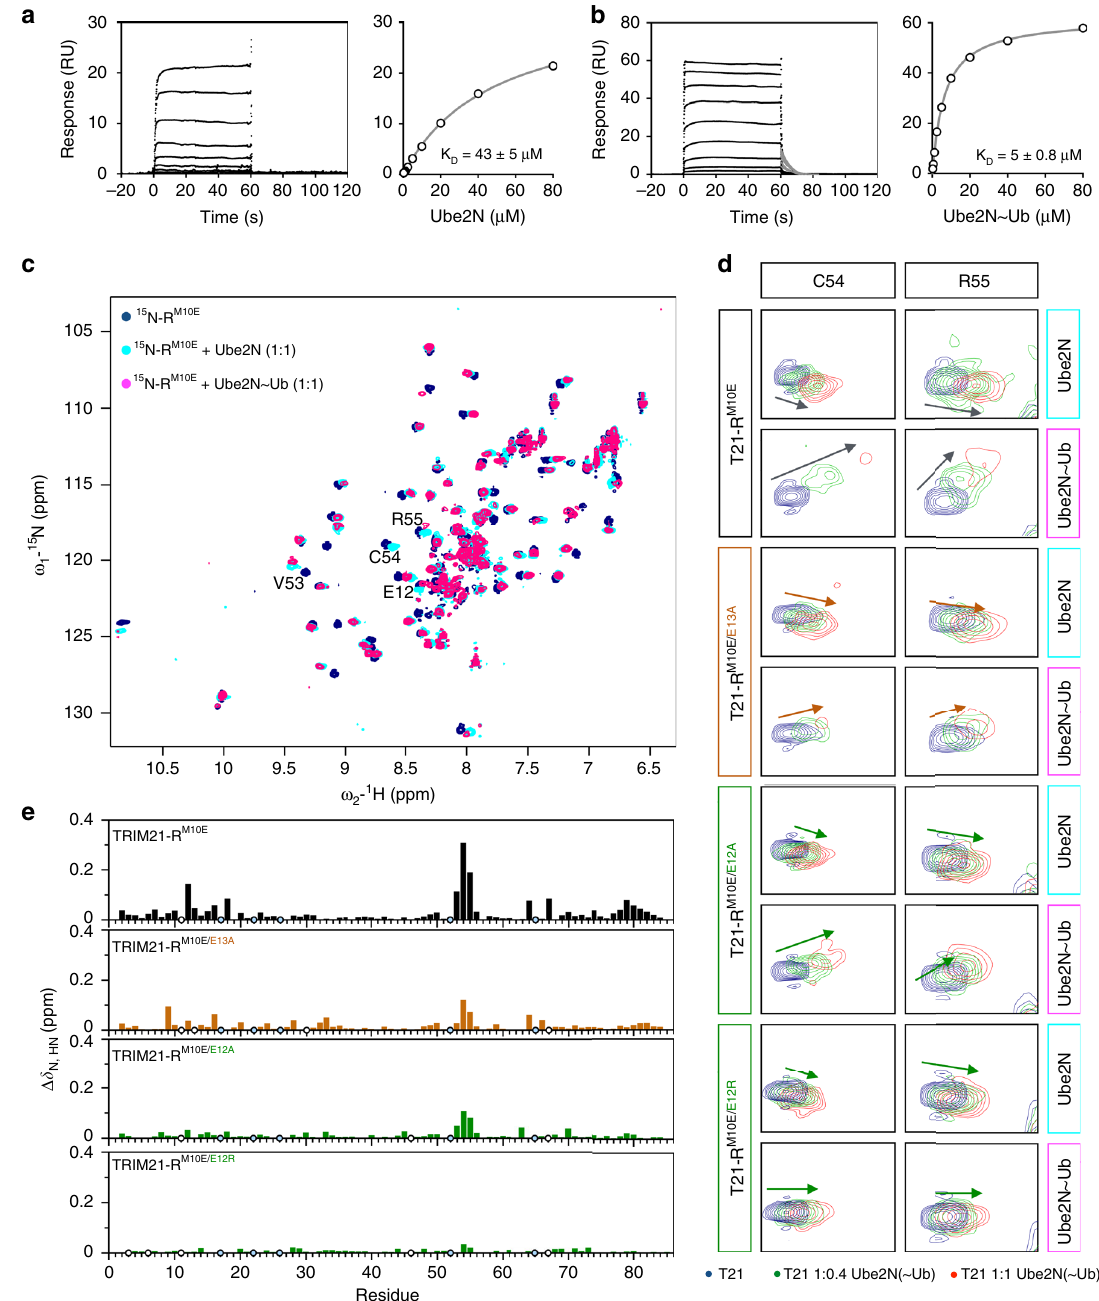
Fig. 3 The tandem glutamates cooperatively promote formation of the closed Ube2N~Ub conformation. SPR sensograms and binding plots for immobilized GST-T21-R titrated against a Ube2N and b Ube2N~Ub. The dissociation of Ube2N~Ub could be fi tted (gray) with dissociation constant ( k off ) of 0.15 s -1 . For Ube2N, the dissociation was faster than the instrument response with the response returning to baseline at the end of injection, suggesting k off to be > 1 s − 1 . The data of replicates are shown in Supplementary Fig. 4. K D values represent the mean ± s.d. of two (Ube2N) or three (Ube2N~Ub) independent experiments. c 15 N-HSQC spectra of labeled T21-R M10E in alone (blue), in presence of Ube2N (cyan), or Ube2N~Ub (magenta) are shown. d The peaks of amide C54 and R55 are shown during titration with Ube2N and Ube2N~Ub. Free T21-R M10E (blue), T21-R M10E in presence of 0.4 (green) and 1 (red) molar equivalents of titrant. e Histograms of the dCSP (differential chemical shift perturbation; see Methods section) of T21-R M10E mutants titrated with either Ube2N or Ube2N~Ub are shown against the primary structure. Blue circles indicate proline residues, white circles missing assignments. Full spectra are shown in Supplementary Fig. 8. Source data are provided as a Source Data fi observed for T21-R E12A . T21-R E13R activity was reduced further. (Fig. 4b, c). These ubiquitination assays correlate well with the Consistent with the role of E13 in capturing ubiquitin by binding NMR titrations, where E12A and E13A each show a similar K11, the ability of T21-R to catalyze the formation of free ubi- reduction in dCSP and E12R shows no dCSP at all (Fig. 3e). quitin chains was abolished when Ub K11E was used (Fig. 4d). Moreover, these biochemical results establish the tri-ionic anchor Mutation of D21 to arginine also resulted in a loss of activity points as key residues in catalyzing ubiquitination with Ube2N.